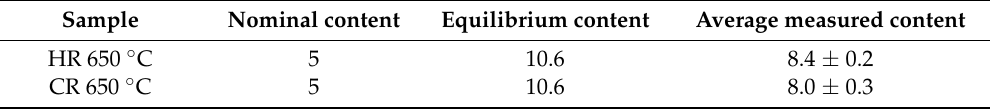
Figure 8. ( a ) XRD patterns of the experimental steel, SEM micrographs of the tensile fracture at different magnifications: ( b , c ) HR 650 ◦ C, ( d , e ) CR 650 ◦ C, and ( f ) CR 675 ◦ C (ND: normal direction, TD: transverse direction). Table 2. The nominal, equilibrium and measured Mn content in austenite